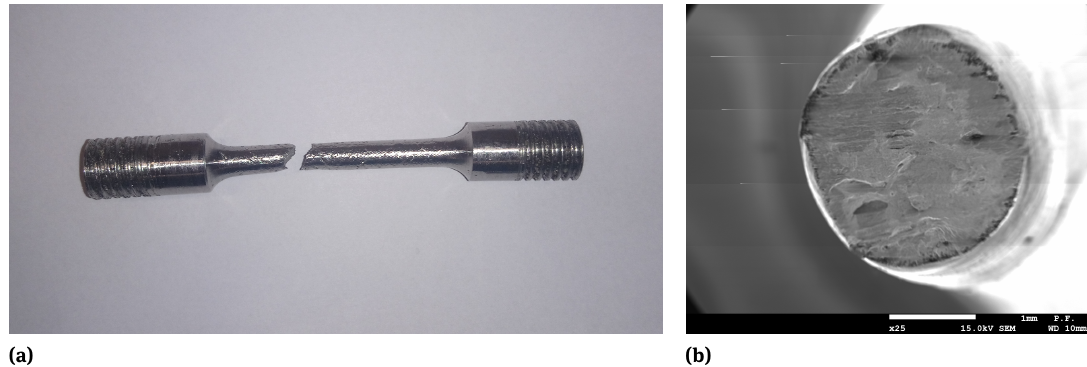
Figure 4: Results of tensile test and fracture results of material stretched in normal conditions